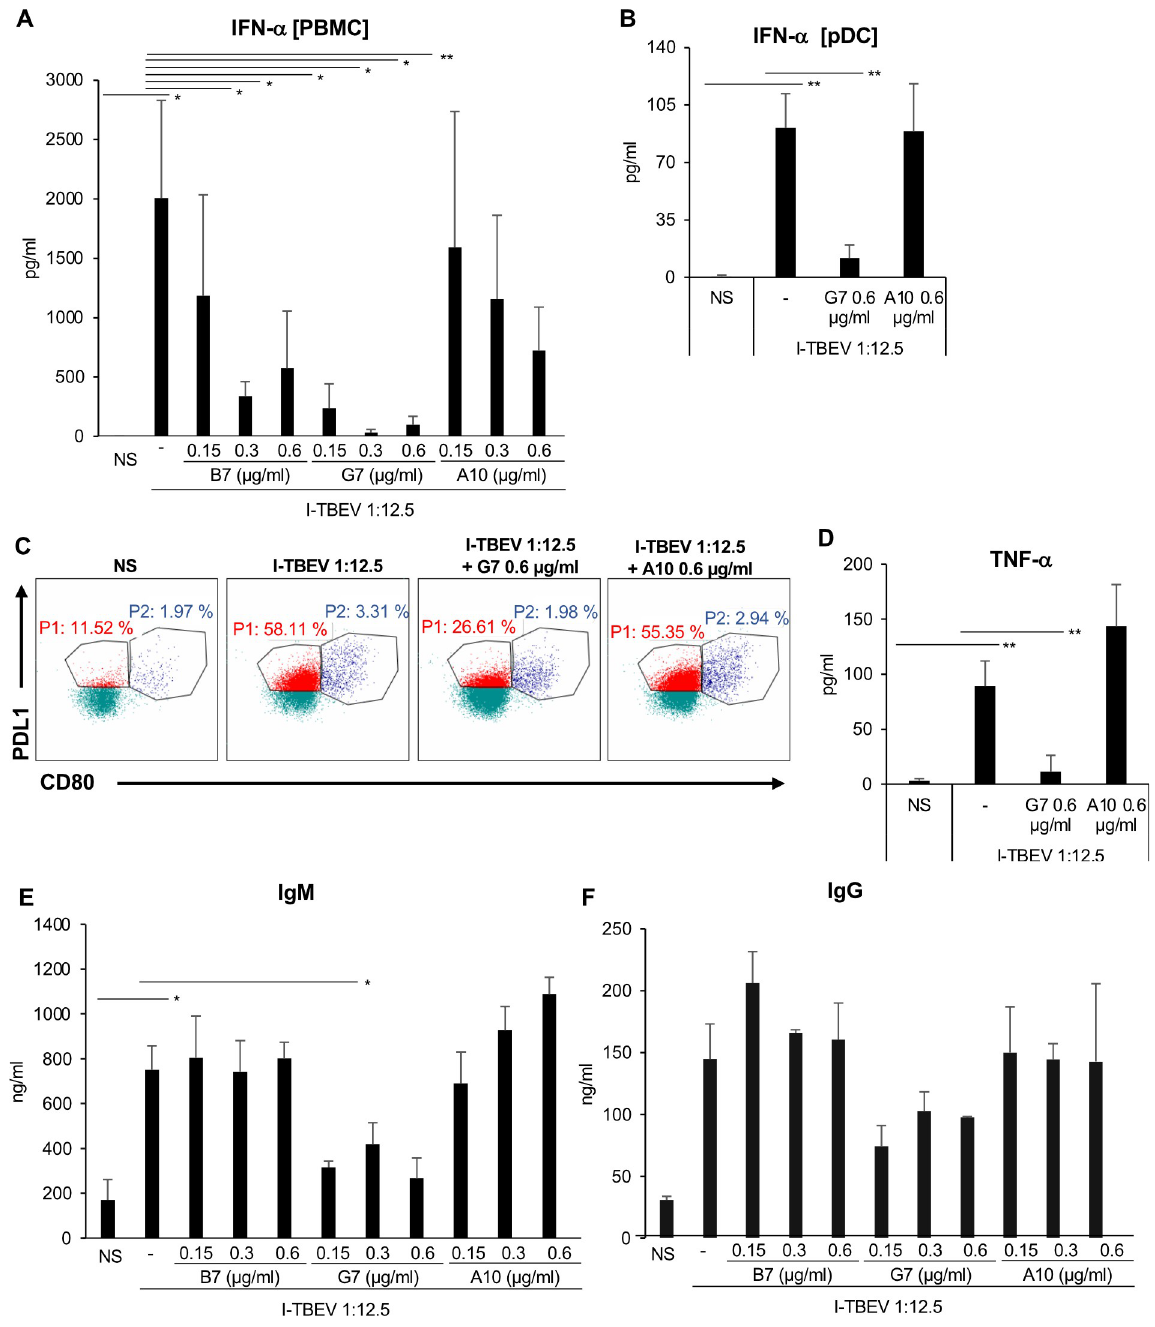
Fig 6. Impact of TBEV E glycoprotein neutralization on IFN- α and Ig production. Total PBMC or isolated pDC were left untreated (NS) or stimulated with I-TBEV (dilution 1:12.5) alone or in combination either with two single-chain Ab (scAb) blocking TBEV E glycoprotein, B7 and G7 or with a scAb non-related to TBEV, A10 clone. (A) The release of IFN- α was measured by ELISA in culture supernatants of total PBMC left untreated (NS) or stimulated for 24 hours with I-TBEV alone or in combination either with B7 and G7 or with a non-related scAb A10 clone at the concentration of 0.15 μ g/ml, 0.3 μ g/ml and 0.6 μ g/ml. The results shown were mean values ± standard error of the mean (SEM) of 3 independent experiments. ANOVA p value for IFN- α : 0.006. Based on LSD (equivalent to no adjustments). (B-D) Isolated pDC were left untreated (NS) or stimulated with I-TBEV alone or in combination either with G7 clone (0.6 μ g/ml) or with A10 clone (0.6 μ g/ml) for 24 hours. The production of IFN- α (B) was measured by ELISA in culture supernatants. The results shown were mean values ± SEM of 3 independent experiments. ANOVA p value for IFN- α : 0.000. Based on LSD (equivalent to no adjustments). (C) pDC were stained with PD-L1, HLA-DR, CD86, CD80, ILT7, BDCA2 and BDCA4. A total of 50.000 cells were analyzed per sample by flow cytometry to evaluate the percentage of pDC sub-populations. A representative pDC sub-population profile out of 3 different experiments conducted separately is shown: P1-pDC (PD-L1 +